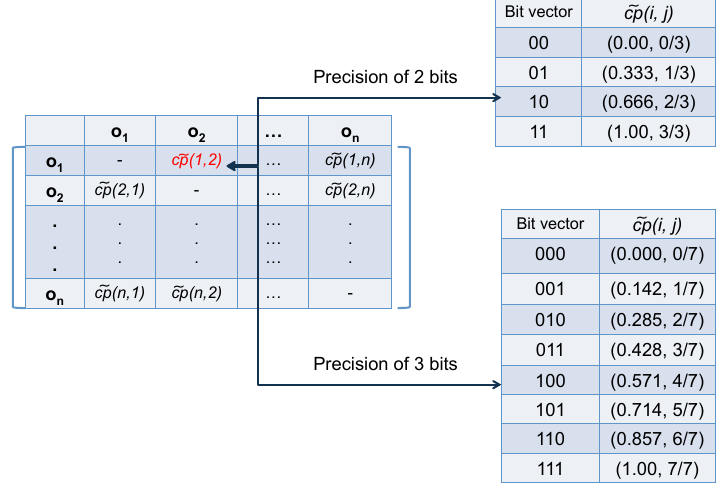
Figure 2. Illustration of the matrix of fuzzy concordance degrees represented with a precision of 2 and 3